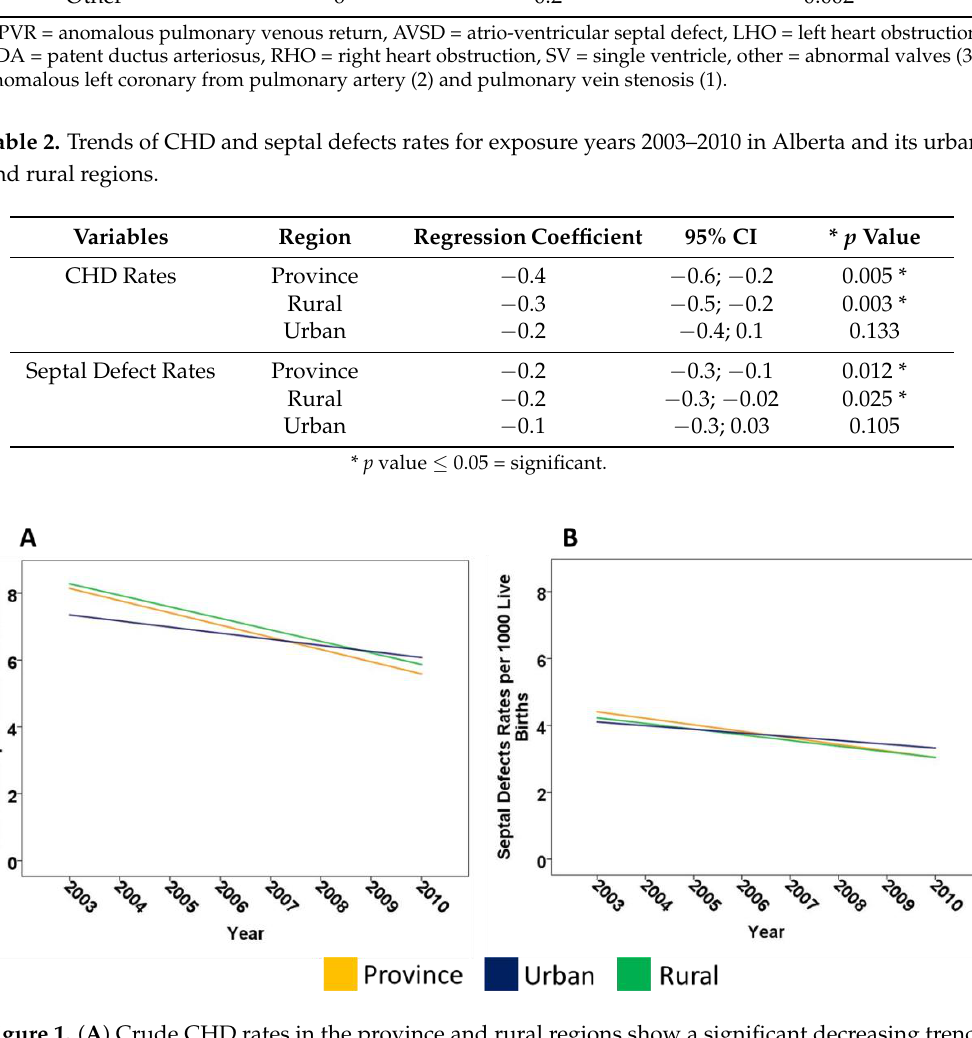
Figure 1. ( A ) Crude CHD rates in the province and rural regions show a significant decreasing trend, (* p = 0.005 and 0.003, respectively) not found in urban regions ( p = 0.133); and ( B ) crude septal defects rates showed a significant downward trend in the province and rural regions (* p = 0.012 and 0.025, respectively), but not urban regions ( p = 0.105).